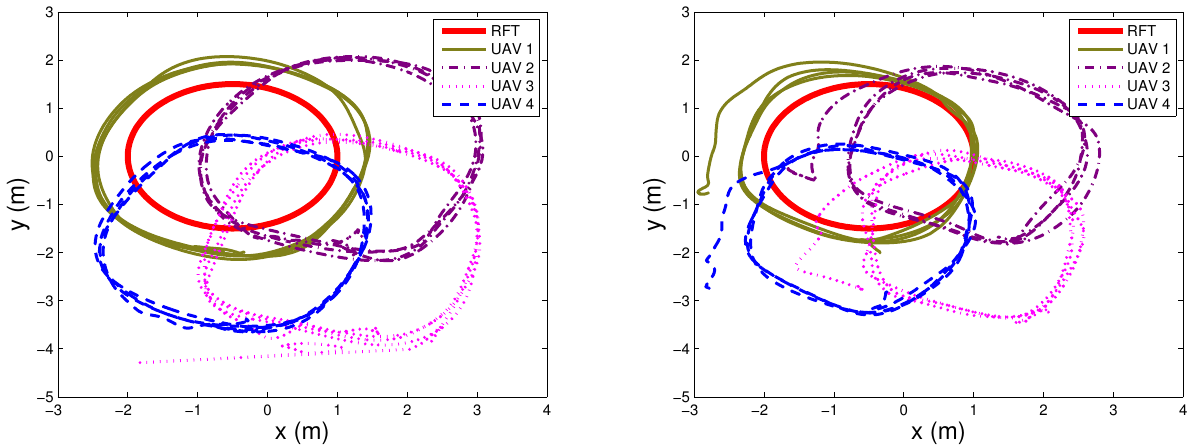
Figure 9. The real-time four quadrotors formation. Left : Formation control without high-order feedforwards; Right : our proposed method.